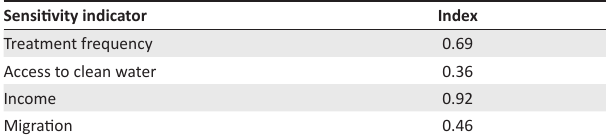
TABLE 2: Sensitivity index.